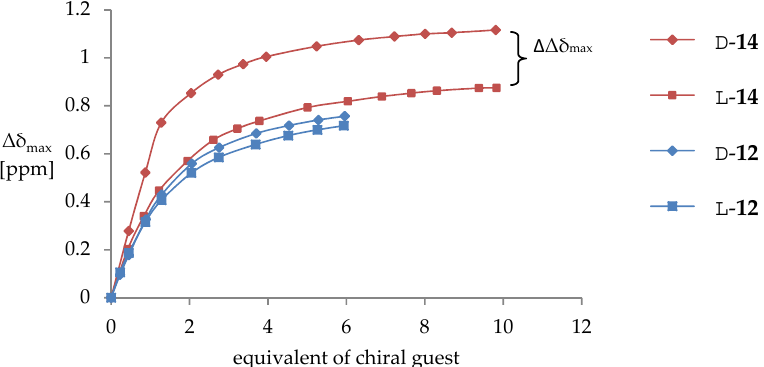
Figure 4. Comparison of the chemical shifts changes for the amide NH protons of receptor 1 ( δ 9.05 ppm) upon addition both enantiomers of N -Ac- α -amino acids 12 and 14 (acetone– d 6 + 0.5% H 2 O, T = 298 K, 400 MHz); points show experimental data, the line is the fitted chemical shift data.